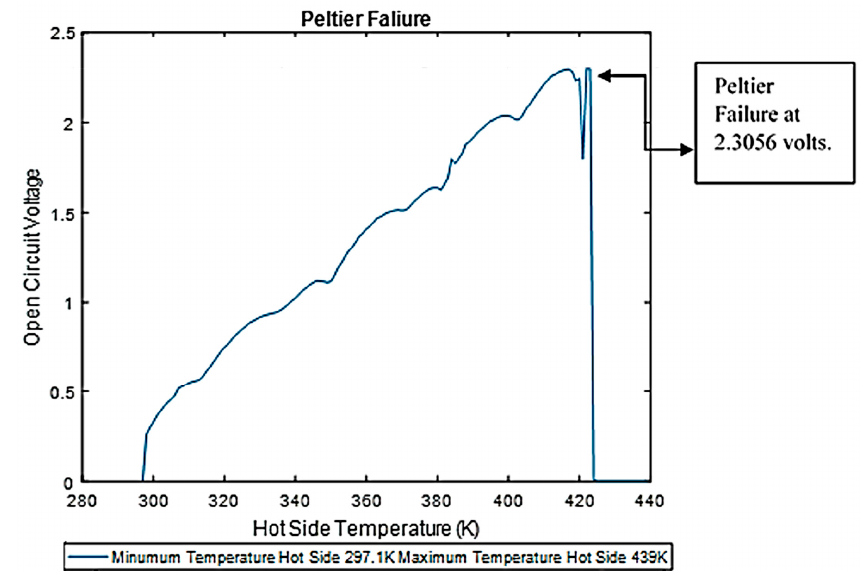
Figure 14. Peltier electrical failure mode shows the V oc performance of TEG (SP1848-27145) subjected to minimum and maximum temperatures of 297.1 K and 439 K,